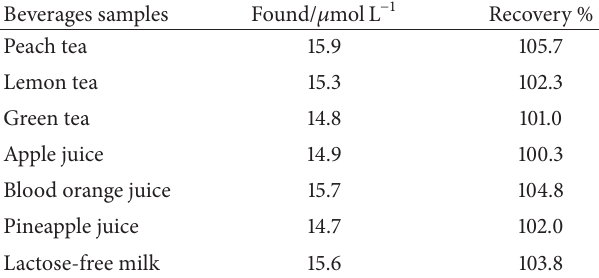
Table 7: Determination of H 2 O 2 in several commercial beverages, spiked with H 2 O 2 15 𝜇 molL −1 , using NAF-MWCNTs-COOH-MG- SPE-CAT as